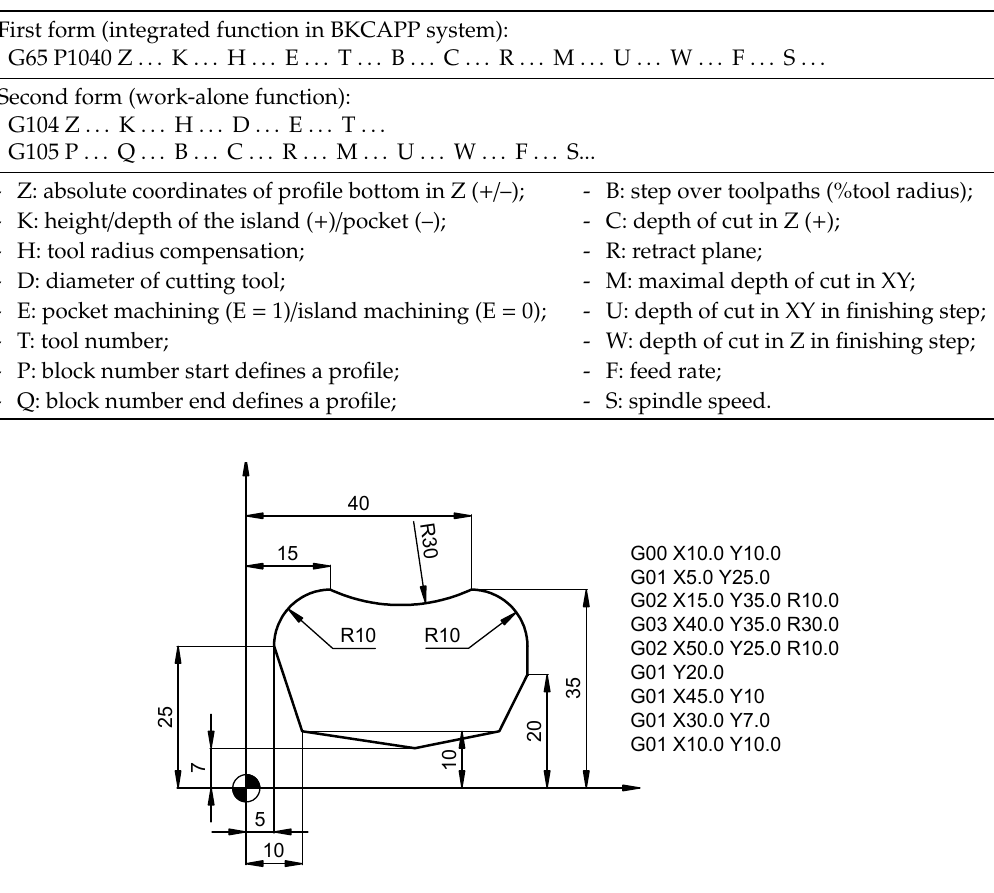
Table 3. Two G-code forms for contour features.